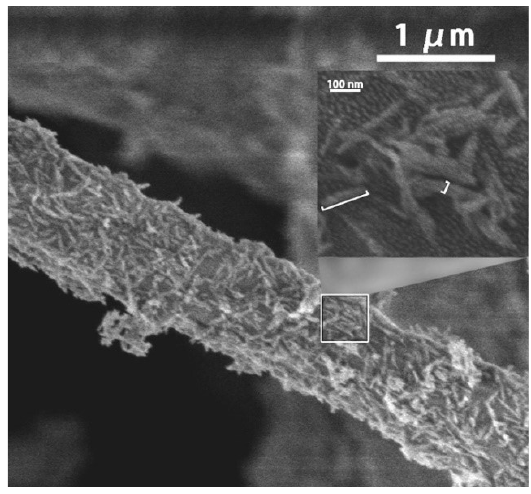
Figure 4. SEM of PDLLA/nHA composite fibers and partially enlarged detail.